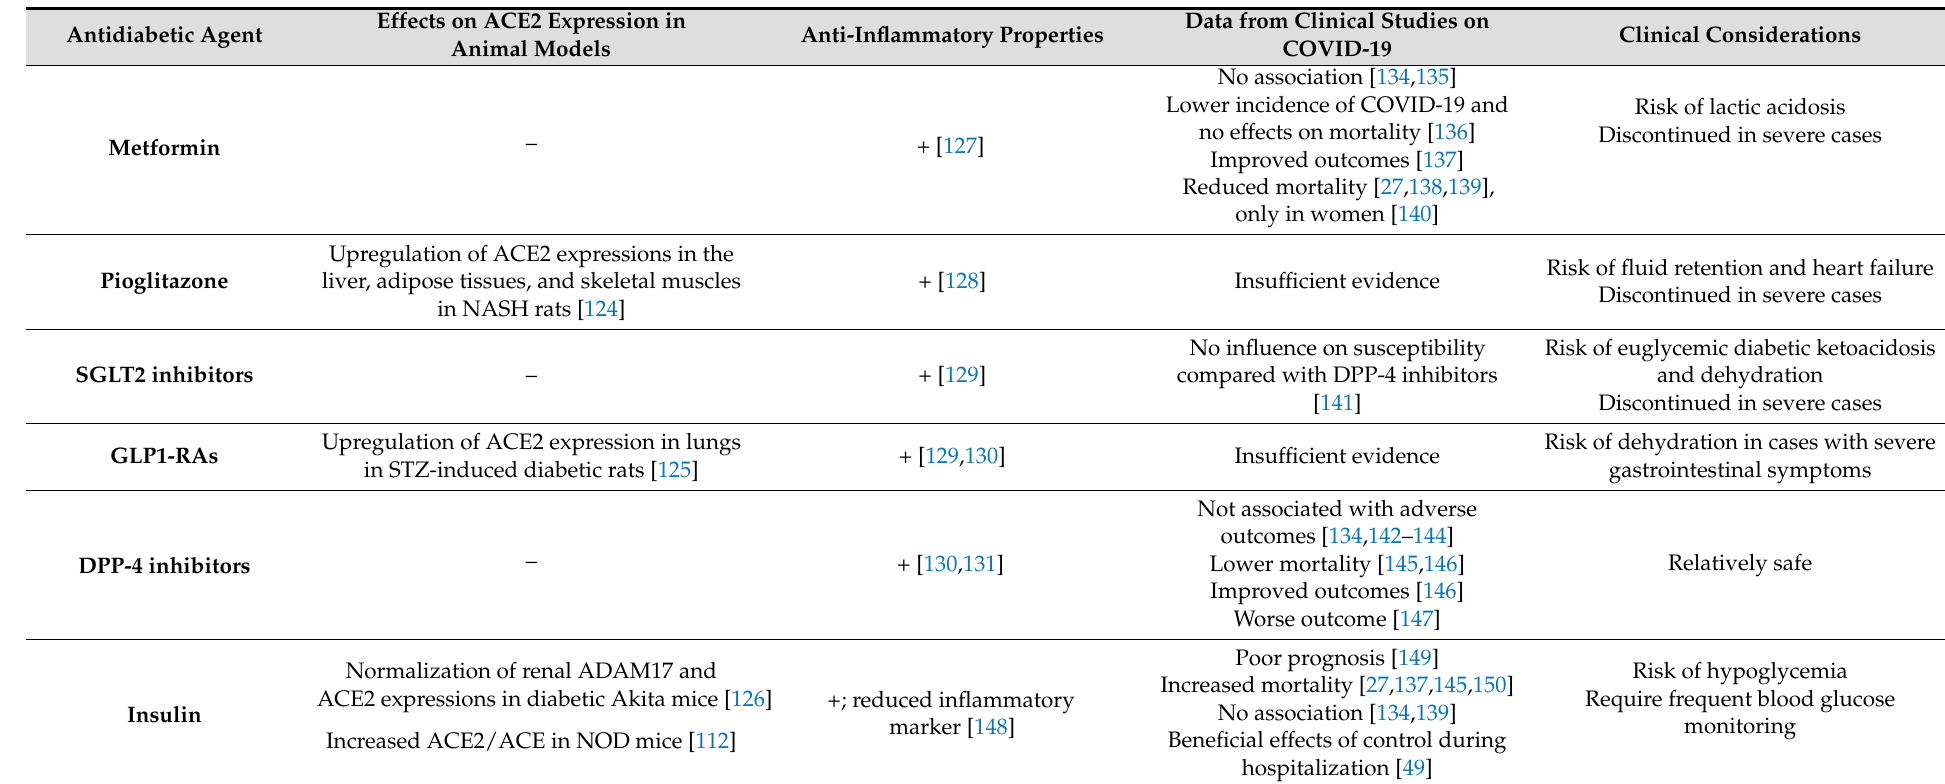
Table 2. Potential roles of antidiabetic agents and related clinical data in COVID-19